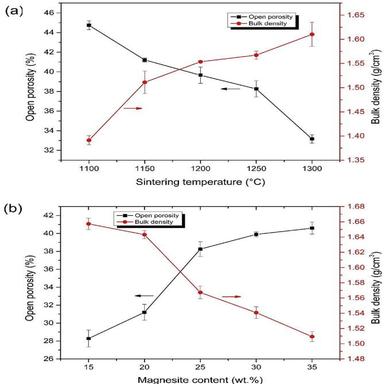
The open porosity and bulk density of the samples. (a) S-3 sintered at different temperatures for 2 h and (b) samples with different magnesite addition sintered at 1250 °C for 2 h.